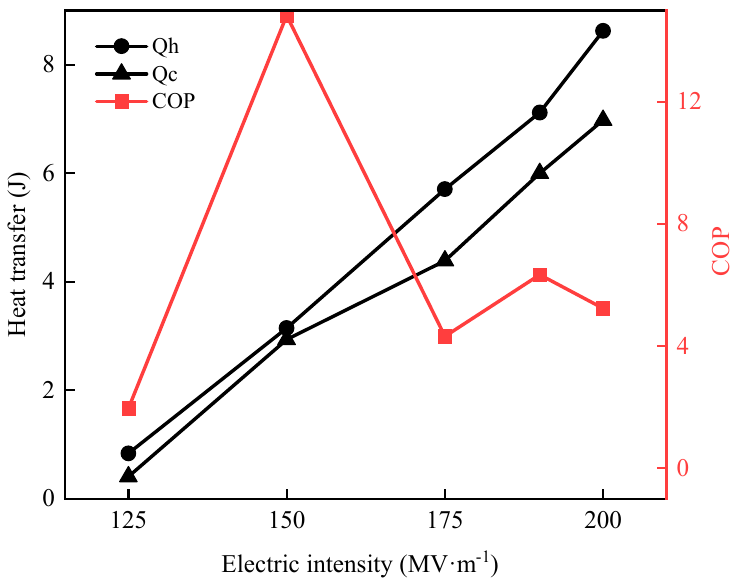
Figure 17. COP at di ff erent electric fi eld intensities.